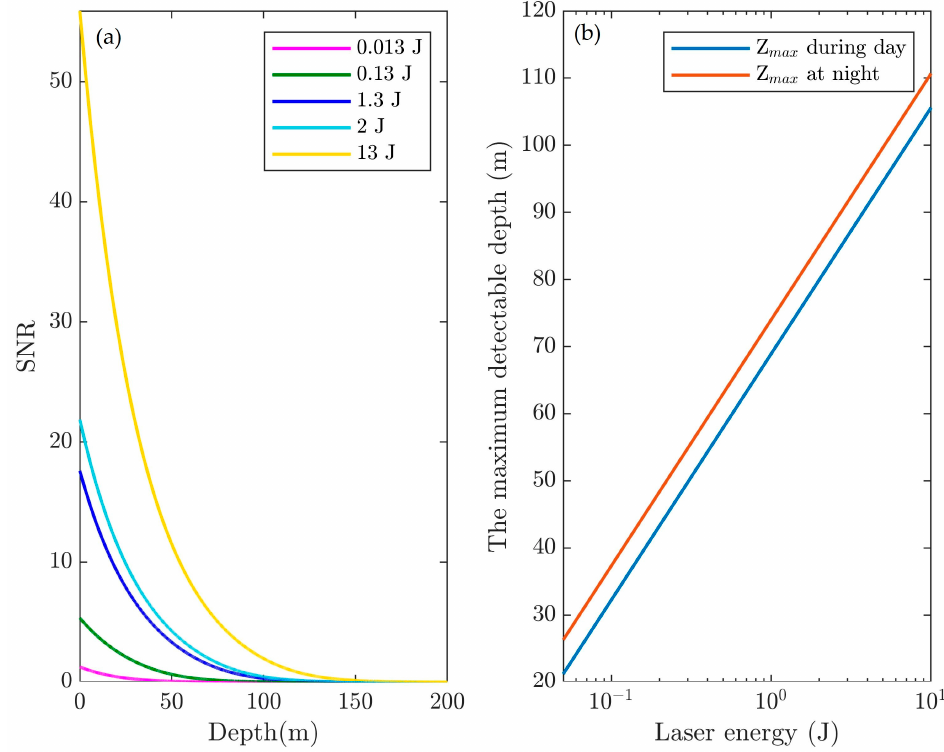
Figure 16. SNR ( a ) for spaceborne lidar with different laser energy powers and the maximum detectable depths versus laser energy ( b ).